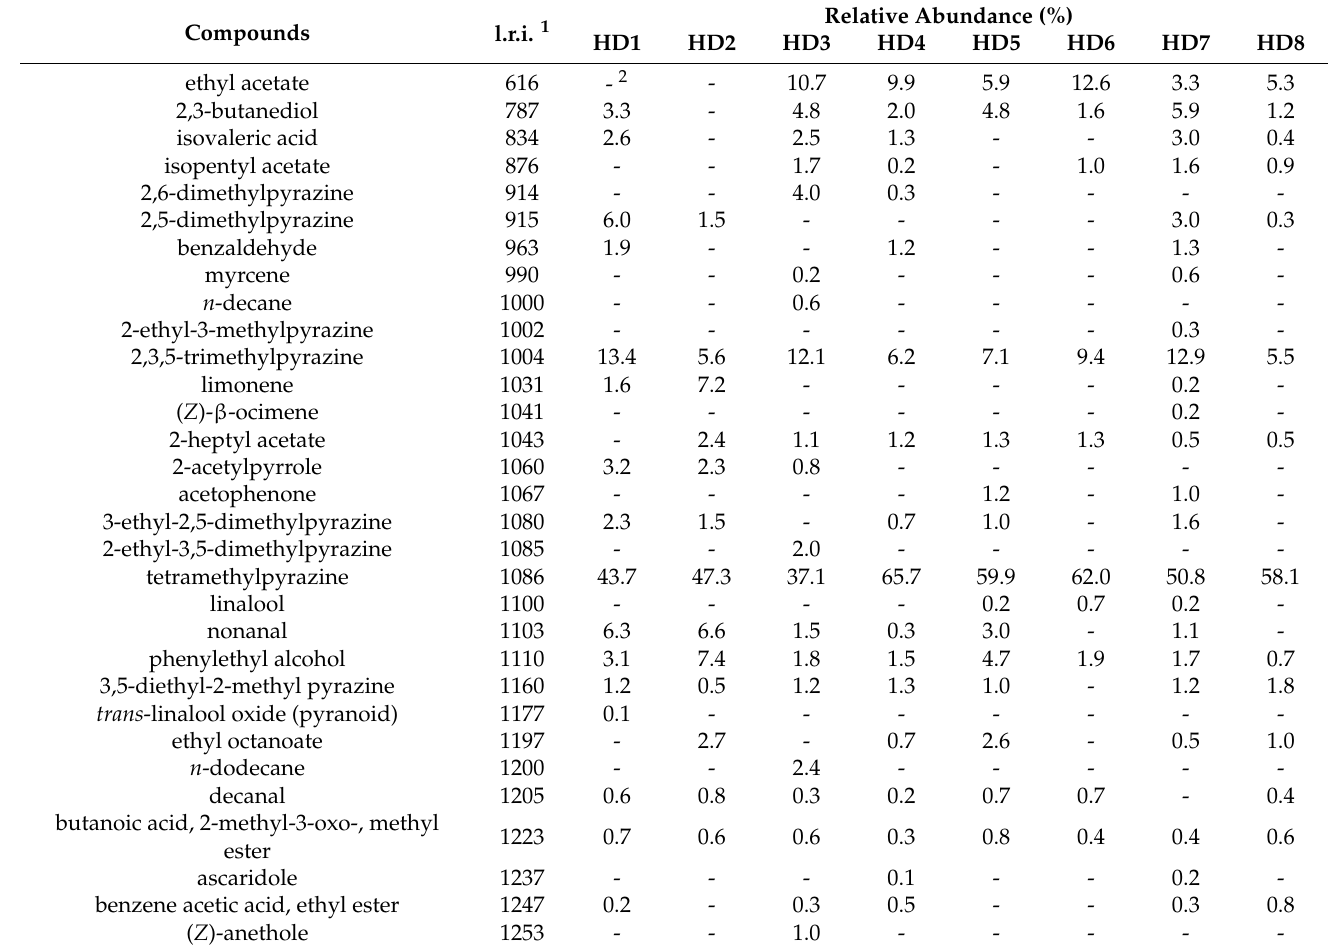
Table 2. Complete compositions of the headspaces sampled for hard-discount chocolate bars (HD1 to HD8).